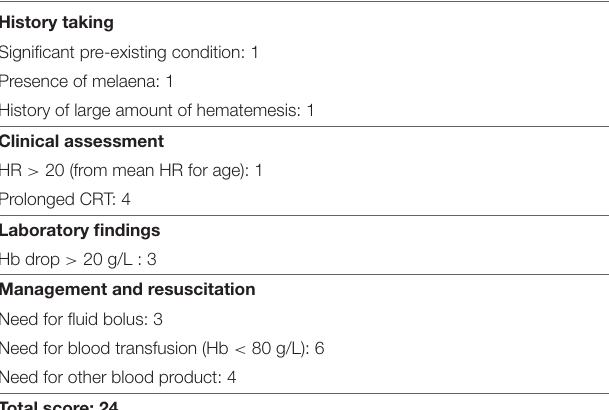
TABLE 1 | Sheffield Scoring